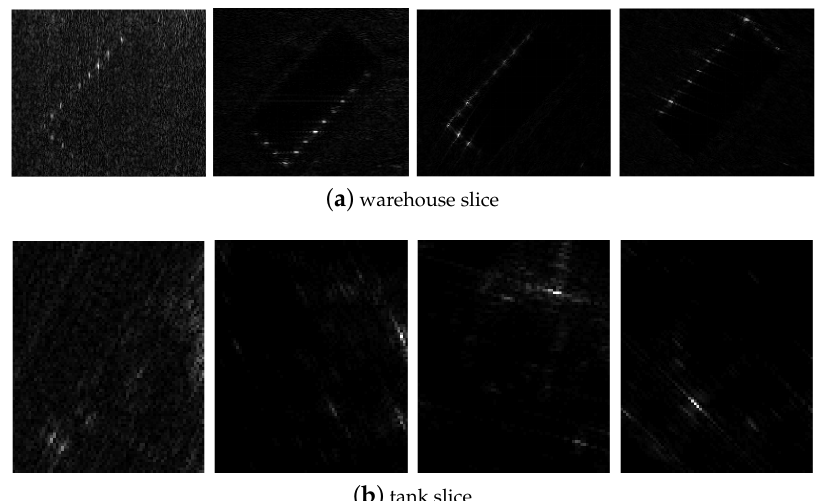
Figure 10. Four angle target slices for warehouse and tank: ( a ) represents 170th, 73rd, 206th, 287th angle warehouse slice; ( b ) represents 199th, 143rd, 92nd, 303rd angle tank slice. Figure 11 aims at the quantitative analysis of the multi-aspect SAR images correspond- ing to the two targets. The four images of two targets in Figure 10 are used for analysis, respectively. The backscattering amplitude values of the target point and the surrounding points are selected for comparison. Figure 11a shows the amplitude values of the target point and the surrounding points in the warehouse. The red dotted circle shows amplitude of the two points at the 170th angle. It can be seen that the backscattering amplitude